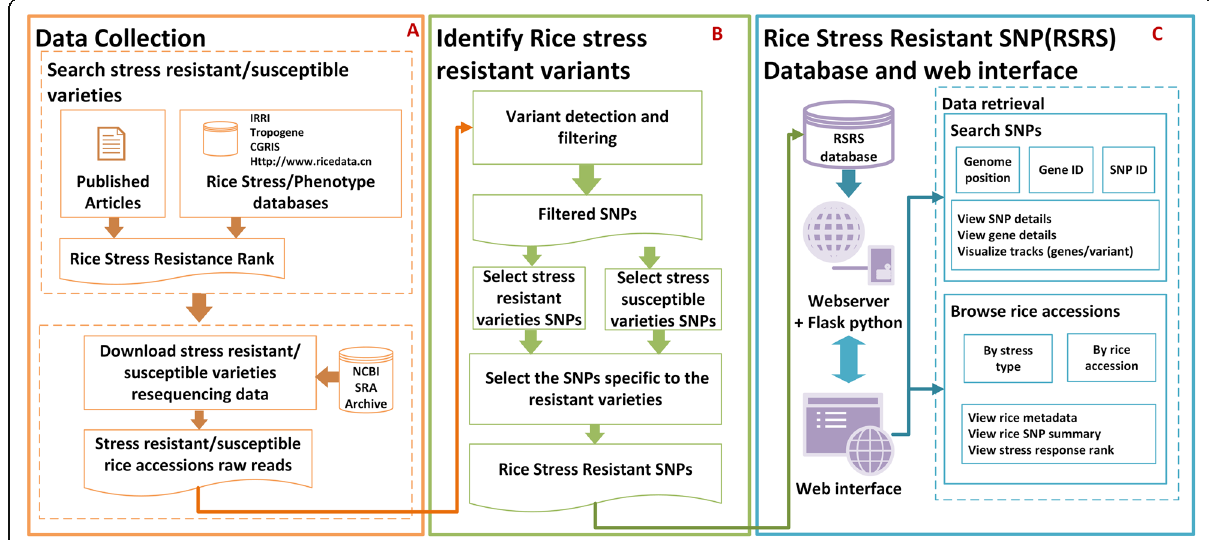
Fig. 1 System view of RSRS database ( a ) Data collection of rice stress resistant/susceptible varieties and their re-sequencing data ( b ) Variant detection of the rice stress resistant/susceptible varieties and identification of the stress resistant specific SNPs ( c ) The RSRS database and web interface design